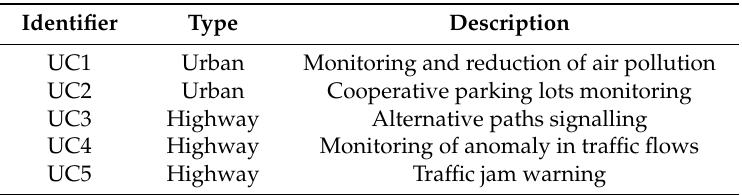
Table 2. Use cases analysed to test the proposed